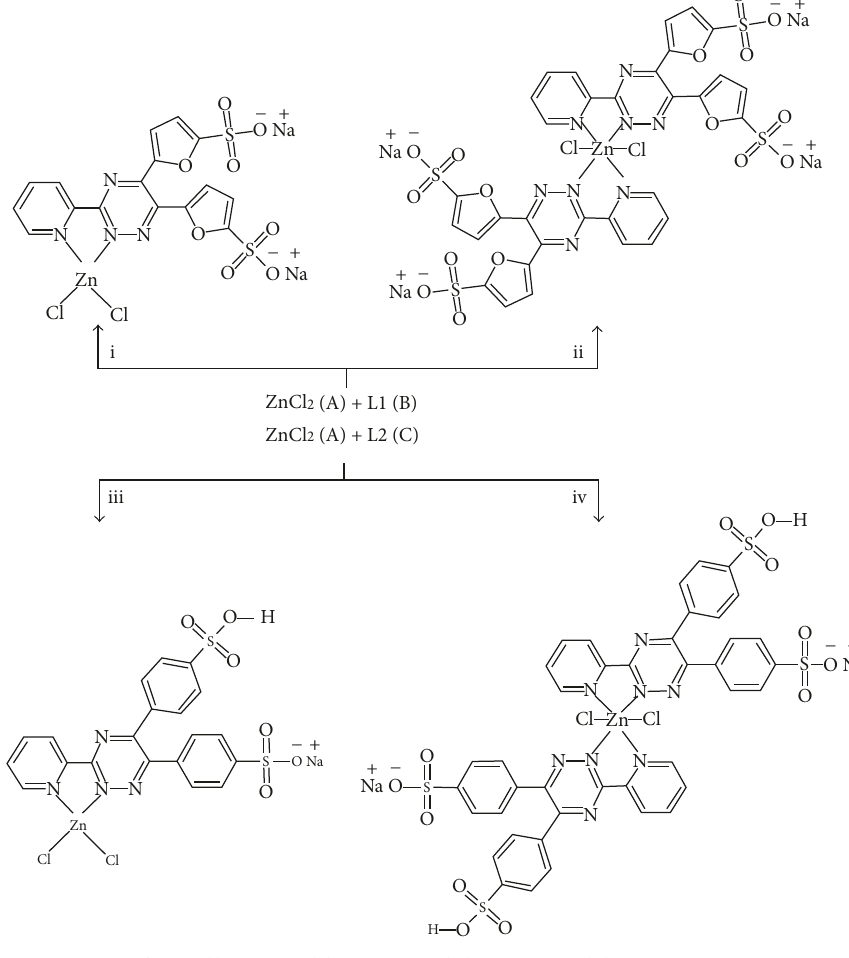
Figure 2: Synthetic routes for the preparation ML1Cl (complex 4 ) (iv) complexes. An associated molecule of ZnCl 2 in complex 1 and solvent molecules in complexes 1–4 have been omitted for